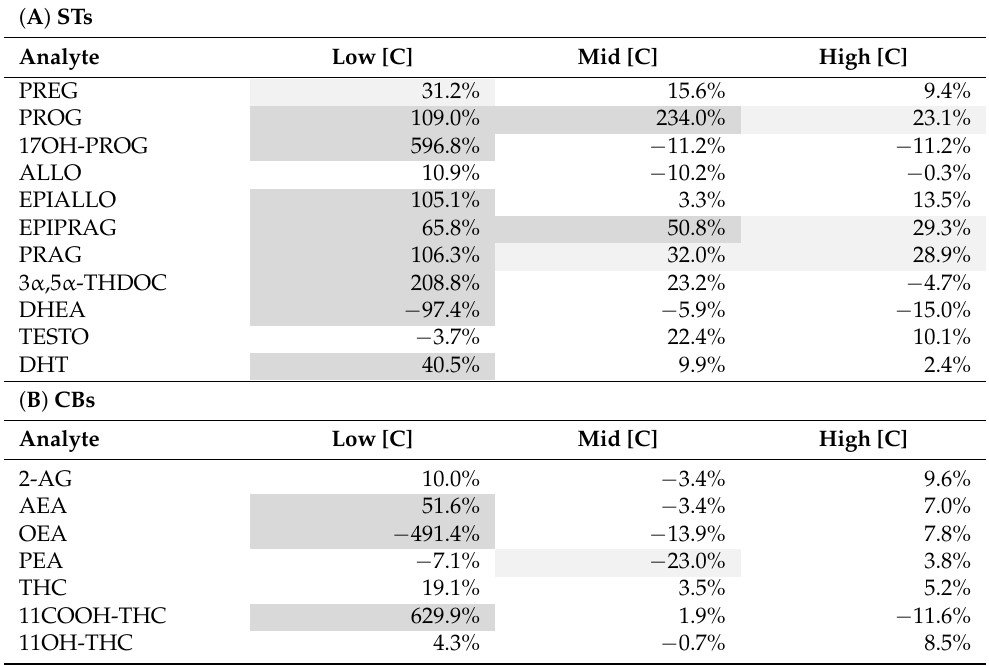
Table 6. Matrix effect for steroids (STs) ( A ) and cannabinoids (CBs) ( B ) expressed as the% difference at low, mid, and high concentration levels [C] (corresponding to CC2, CC4, and CC8 concentration levels, respectively, of the calibration